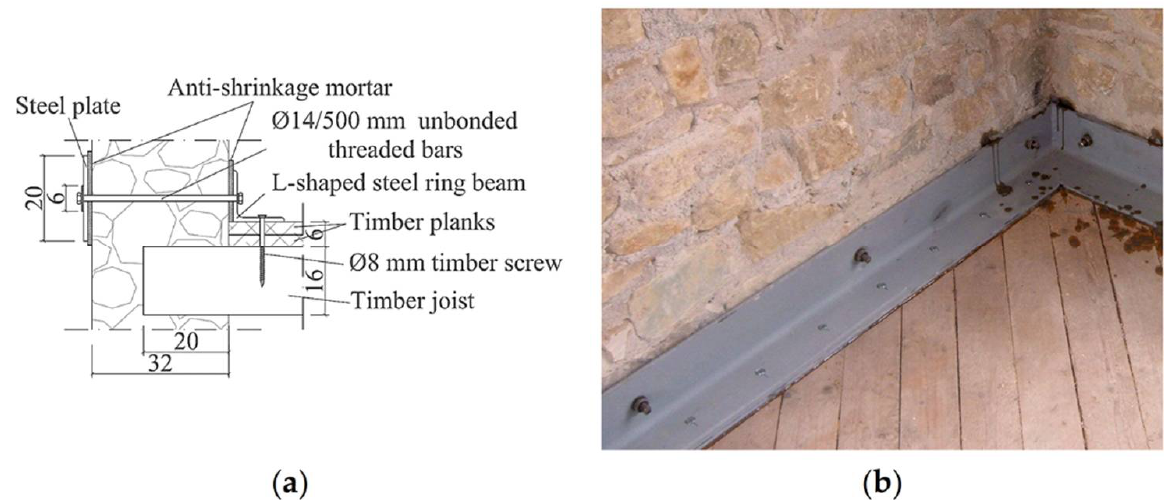
Figure 6. Building 2, retrofit at the first-floor level: ( a ) structural detail of the wall-to diaphragm connection; ( b ) steel-angle ring beam at a building corner and 45-degree-oriented additional timber planks. Units of cm.